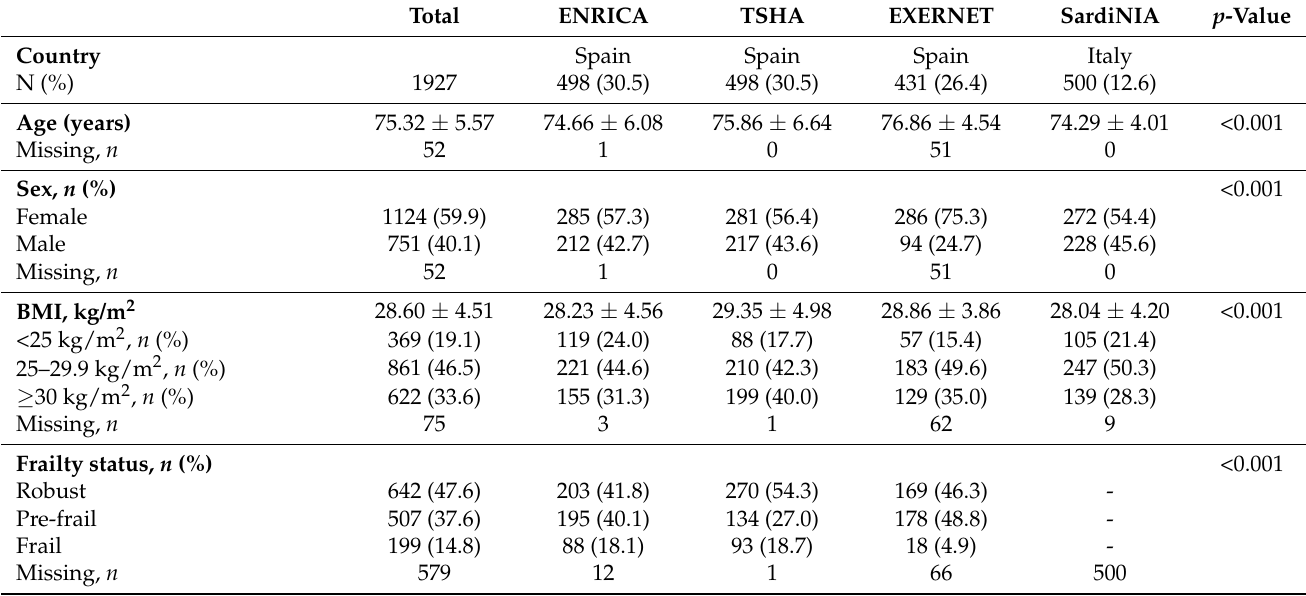
Table A2. Detailed participants’ characteristics by